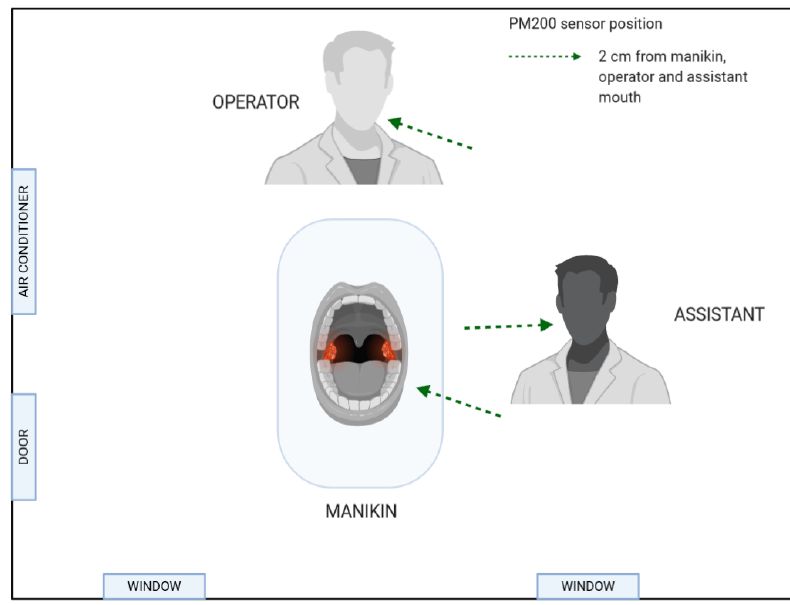
Figure 1. Aerosol particle sensor positions (created in BioRender.com).